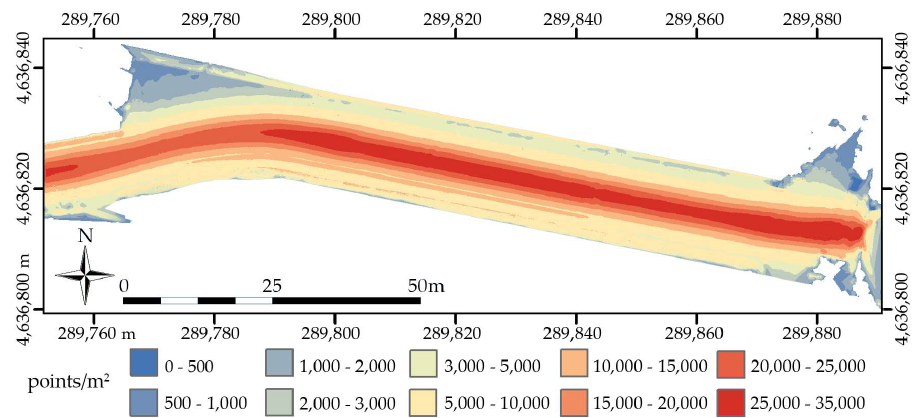
Figure 2. MLS cloud density maps, for a vehicle driving at a speed of 10 km/h.